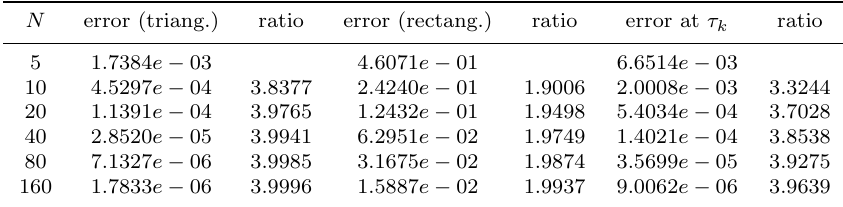
Table 4. Comparison of numerical results for Example 4. N error (triang.) ratio error (rectang.) ratio error at τ k